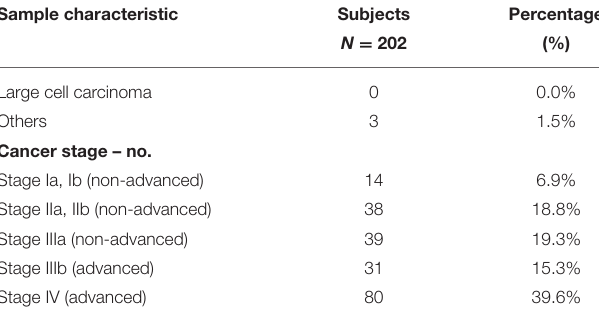
TABLE 4 | Demographics and baseline characteristics of the